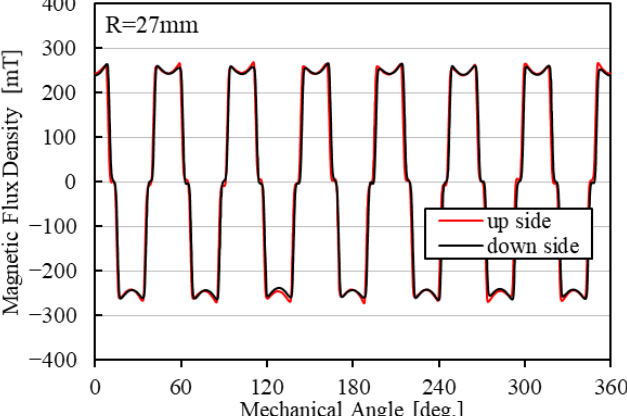
Figure 20. Surface magnetic flux waveform.